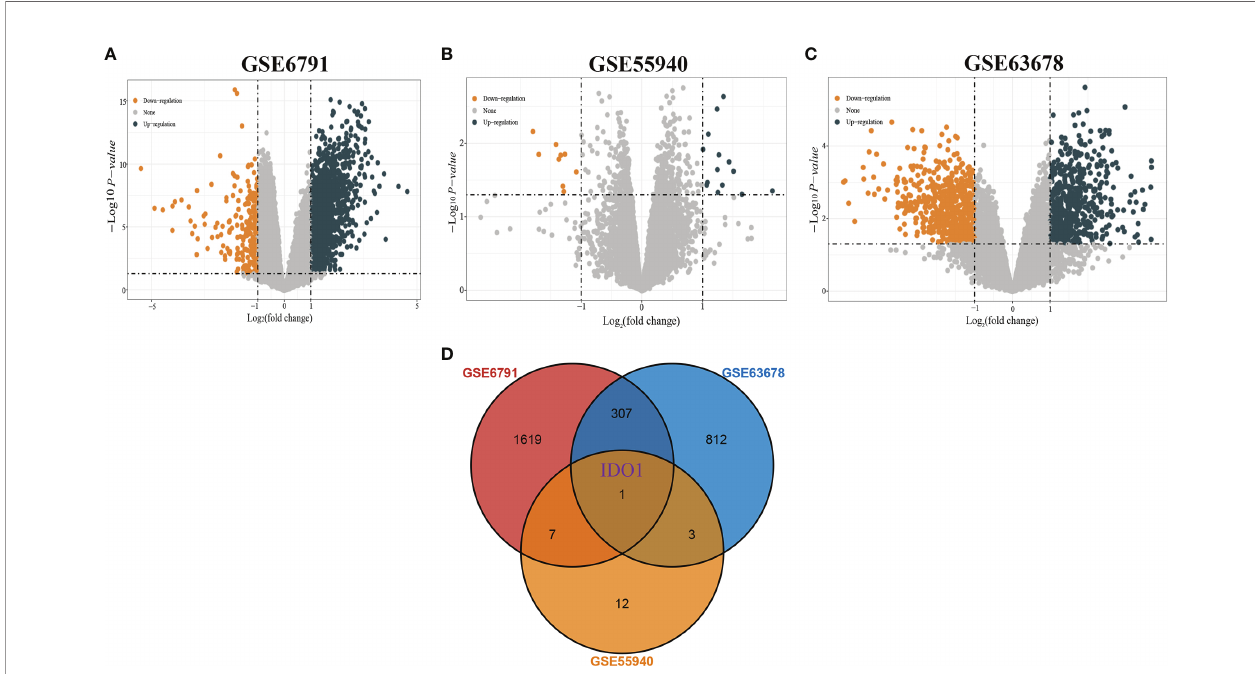
FIGURE 1 | Screening of differentially expressed genes. [ (A) Volcano plot of DEGs in GSE6791; (B) Volcano plot of DEGs in GSE55940; (C) Volcano plot of DEGs in GSE63678; (D) Venn diagram showing overlapping genes of DEGs in the three